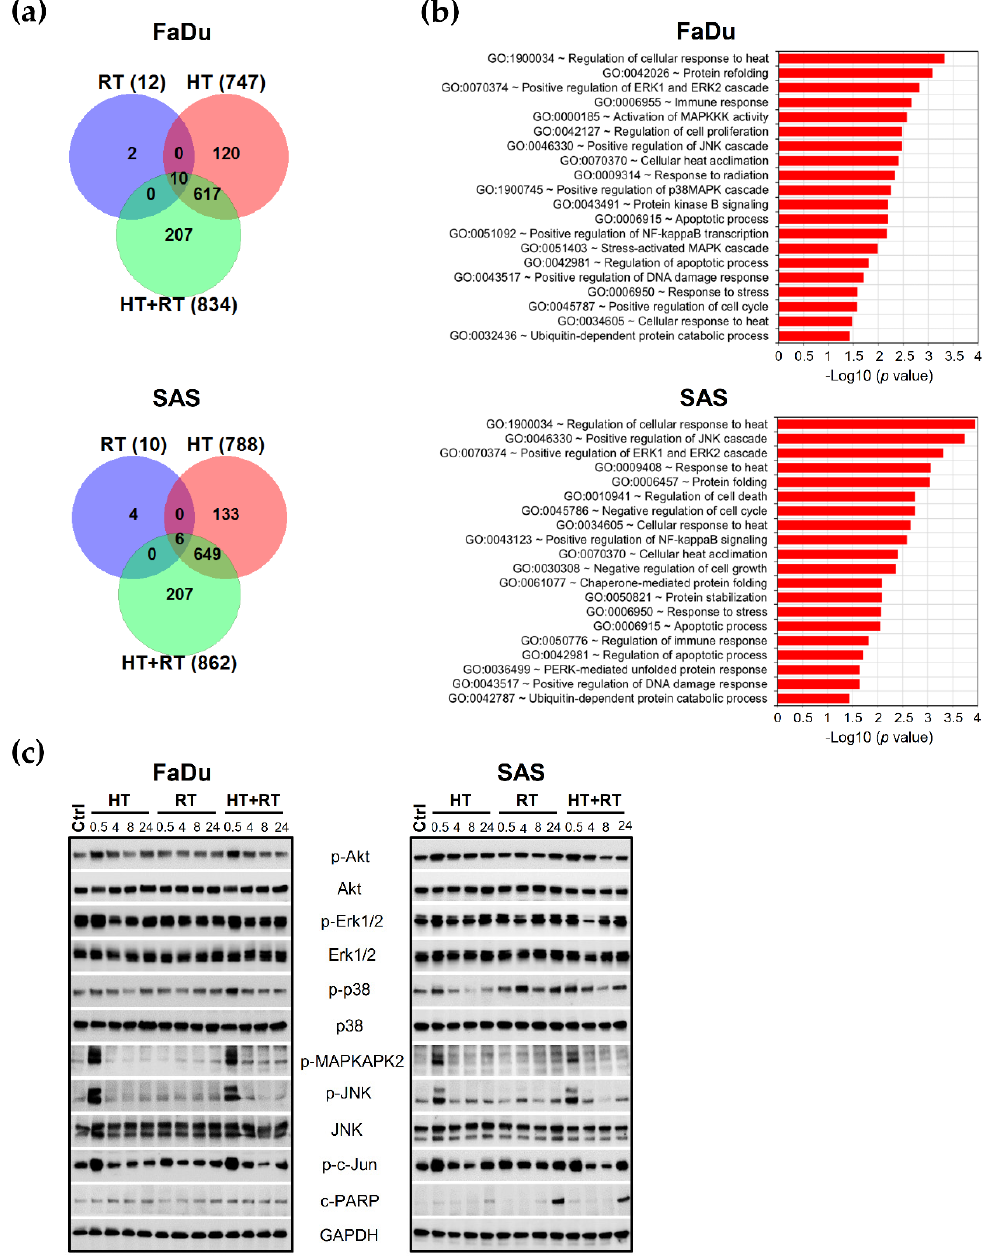
Figure 3. Combination of HT with RT affects the main signaling networks and stress response pathways in HNSCC spheroids: ( a ) Venn diagrams illustrating the number of differentially expressed genes from the whole genome for RT, HT, and HT + RT-treated FaDu and SAS spheroids in triplicate (0.5 h after treatment). Genes were selected by DESeq2 with at least 2-fold changes in expression relative to the appropriate control spheroids (adjusted p ≤ 0.05). ( b ) The top 20 selected signaling pathways and processes that are significantly (2-fold change or more, adjusted p ≤ 0.05) over-represented in FaDu and SAS spheroids 0.5 h after exposure to HT + RT (42.5 ◦ C/60 min; 7 Gy for FaDu and 10 Gy for SAS) when compared to controls using the GO enrichment analysis. The X -axis presents the corresponding adjusted p values according to Fischer exact’s test (in negative log10 scale). ( c ) Representative Western blot data sets showing the expression/activation of proteins of interest from the MAPK and PKB/Akt signaling pathways in the two HNSCC spheroid types upon treatment. GAPDH was used as loading control. Spheroid treatment conditions: Ctrl—control; RT—single dose irradiation (7 Gy for FaDu and 10 Gy for SAS); HT—hyperthermia (42.5 ◦ C/60 min); HT + RT—hyperthermia and single dose irradiation according to mono-treatments.